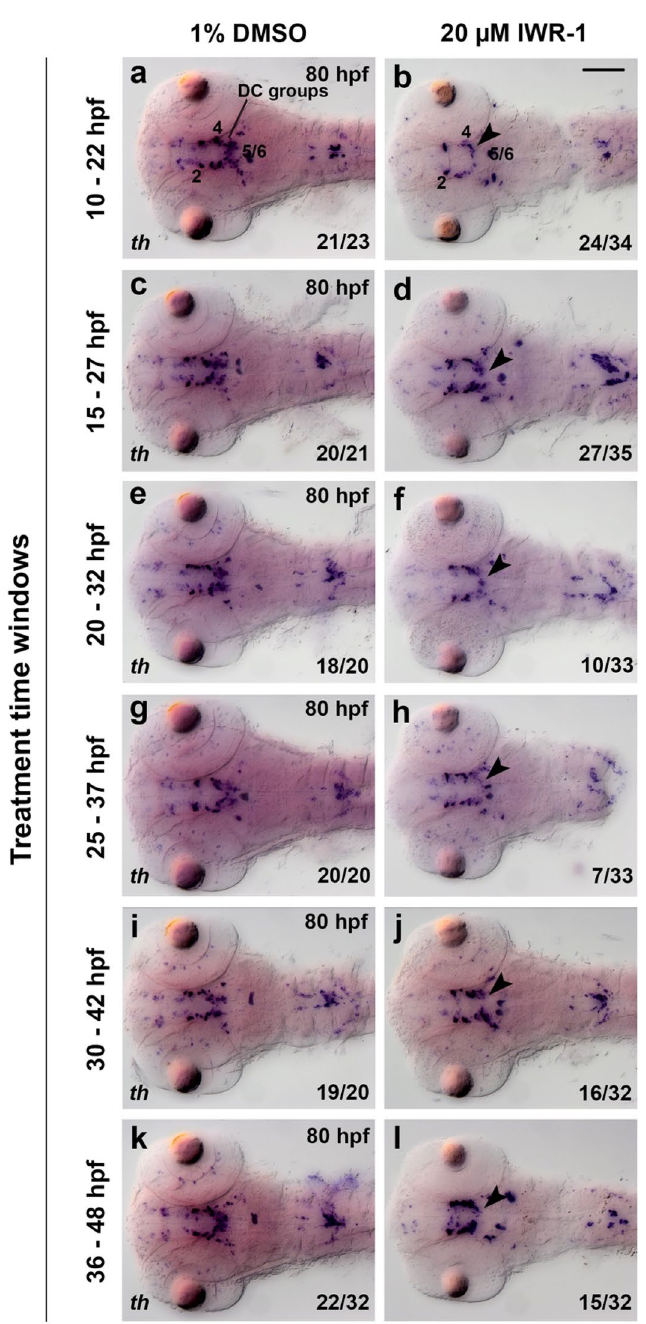
Figure 4. Inhibition of Wnt/β-catenin signaling by IWR-1 affects DA neurons in the ventral diencephalon and hypothalamus. ( a – l ) Expression analysis of the DA neuron marker th by whole mount in situ hybridization in embryos treated with IWR-1 (right) or DMSO (control, left) during time windows indicated on the left side of each row, and subsequently fixed at 80 hpf. The th expressing DC groups 2–6 are indicated in ( a ) and ( b ). The arrowhead in ( b , d , f , h , j , l ) point at decreased th expression in DC5/6 groups. Dorsal views of heads of larvae, images are Z-projections of image stacks. Scale bar in ( b ) is 100 µm for all images. Numbers N/N in bottom right corner of each image indicate number of representative phenotypes as shown in image versus total embryos analyzed for this